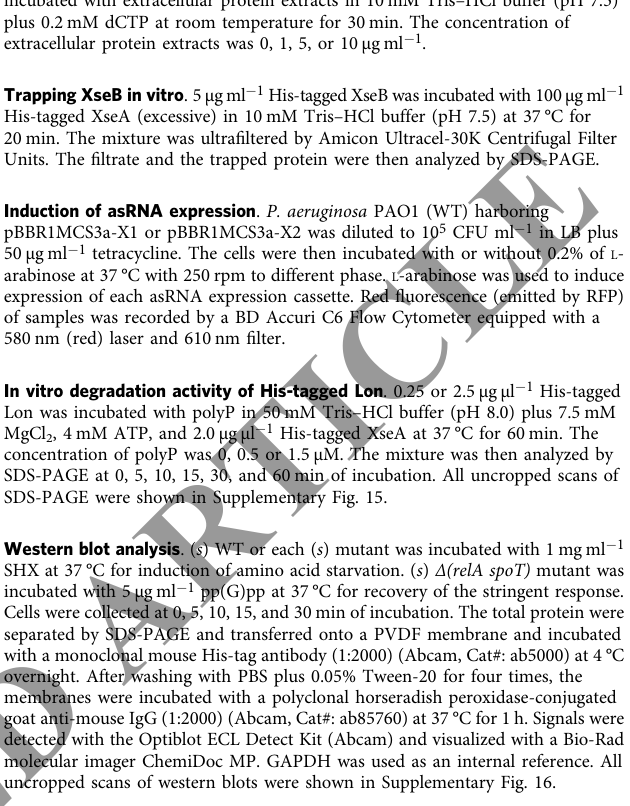
incubated with His-tagged XseB at room temperature for 10min. The concentration of His-tagged XseB was 0, 1, 5, or 10 μ gml − 1 . Activity of extracellular protein in vitro synthesizing poly (dC): A Cy5 fl uorescent label was attached to 5 ′ terminus of poly(dC 4 ). 0.15 mM *poly(dC 4 ) was incubated with extracellular protein extracts in 10mM Tris – HCl buffer (pH 7.5) plus 0.2mM dCTP at room temperature for 30min. The concentration